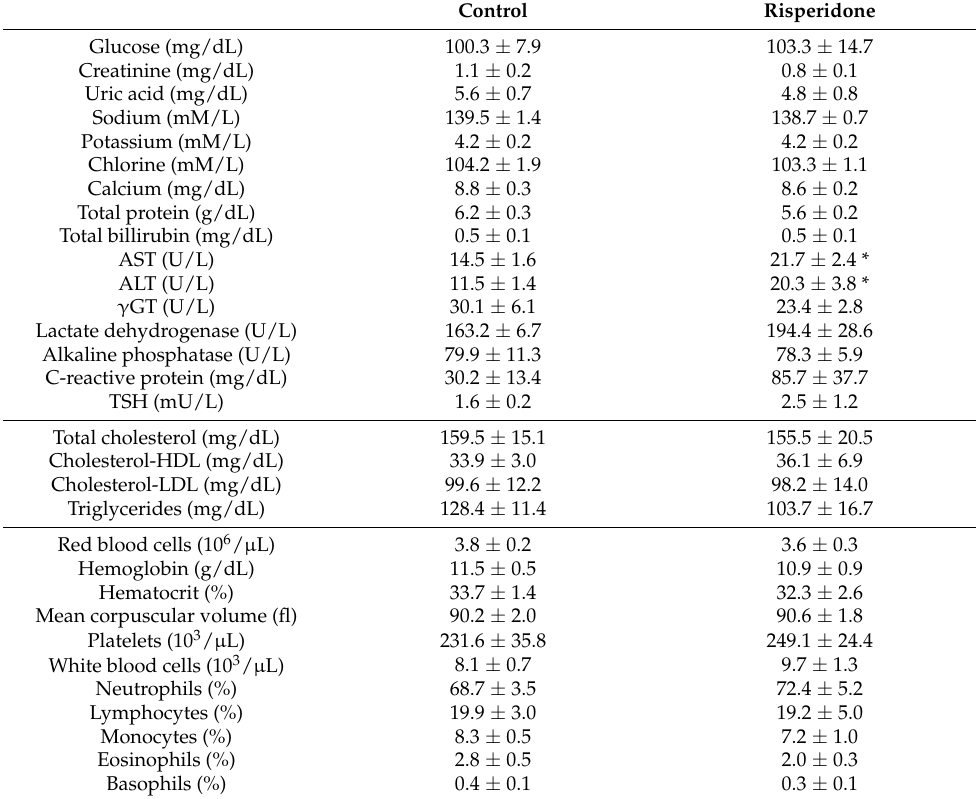
Table 2. Biochemical parameters in serum of non-antipsychotic (control) and risperidone-treated (risperidone) older patients. Results are means ± SEMs, n = 10. Statistical comparisons shown are risperidone vs. control (* p < 0.05). ALT, alanine amino transferase; AST, aspartate amino transferase; γ GT, γ glutamyl transpeptidase; TSH, thyroid-stimulating